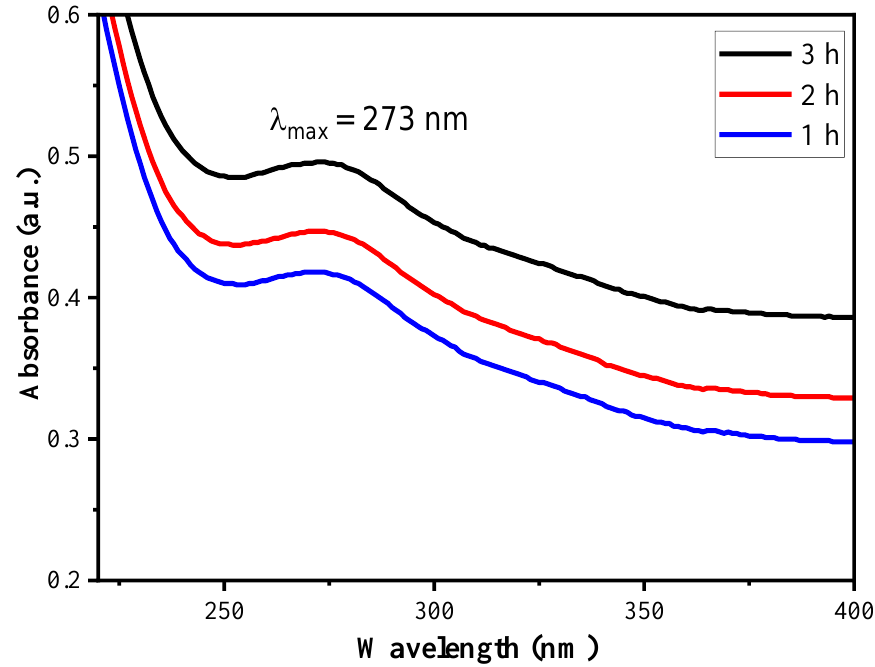
Figure 4. UV-Vis plot of XGFO in wavelength range of 200 – 400 nm.